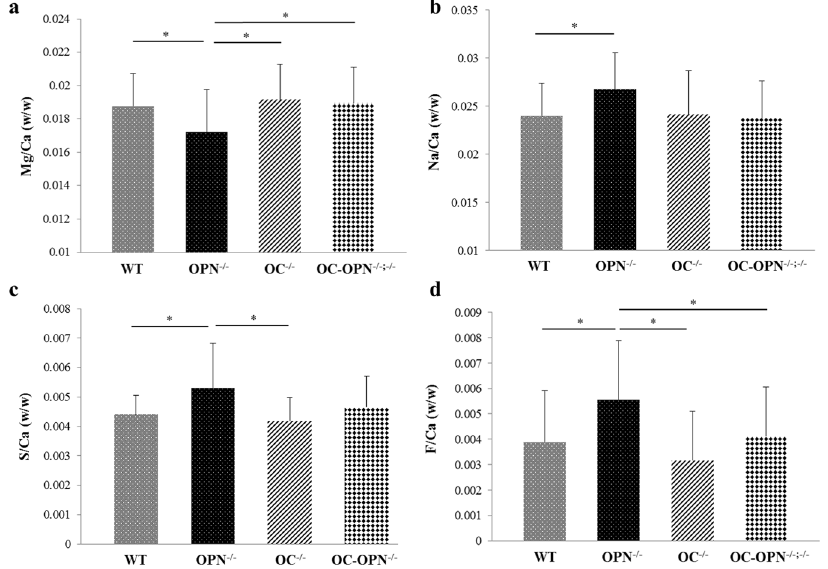
Figure 3. Trace element levels as measured per unit of Ca (w/w), for the elements, Mg (a) , Na (b) , S (c) and F (d)